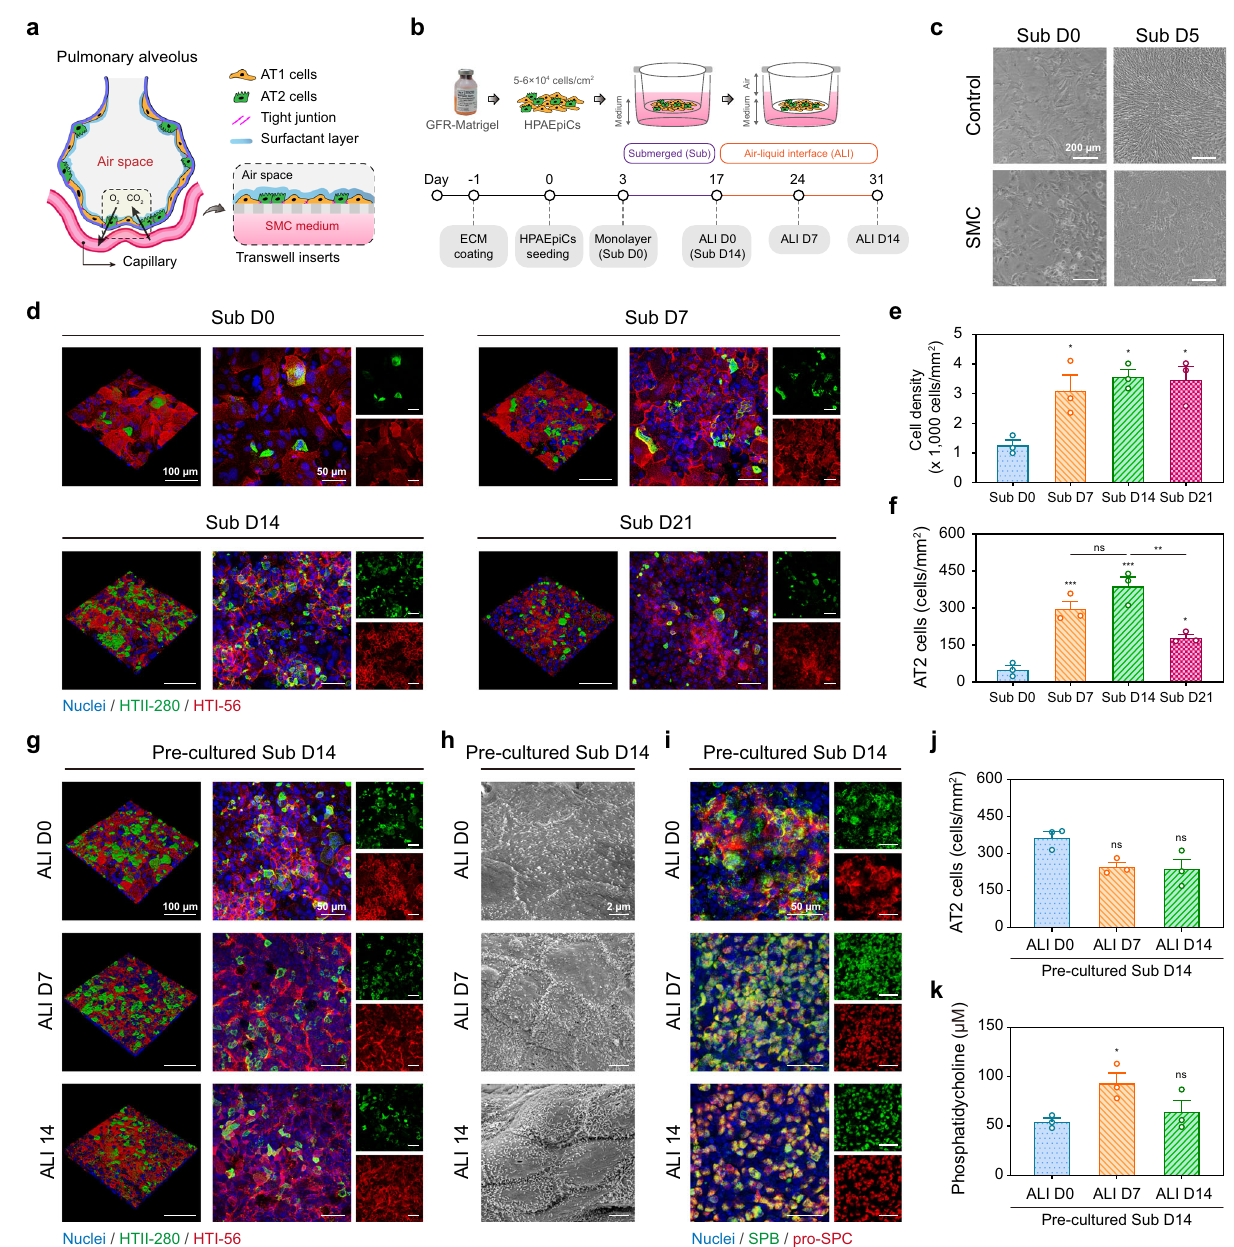
Fig. 3 Reconstitution of functional human alveolar model with ALI. a Schematic of alveolar model containing AT1 cells, AT2 cells, epithelium integrity, and surfactant layer. b Timeline fl owchart showing HPAEpiC culture steps during modeling process. The HPAEpiCs were submerged (Sub) cultured for 14 days, and then, ALI cultured for 14 days. c Bright- fi eld microscope images showing changes in HPAEpiC morphology during the modeling process. In the control medium, cells were almost elongated spindle-shaped after 5 days of Sub-culturing, whereas the SMC medium maintained an epithelial morphology. d During Sub-culturing, HPAEpiCs were stained with HTII-280 (green) and HTI-56 (red) antibodies, which are speci fi c markers for AT2 and AT1 cells, respectively. e Cell-density quanti fi cation for 21 days of sub-culturing. The HPAEpiCs proliferated signi fi cantly in the fi rst 7 days before the proliferation trend gradually stabilized. f Quanti fi cation of HTII-280 + cell (AT2 cells) populations for 21 days of Sub-culturing. The AT2 cell number reached a maximum at 14 days of culturing and then declined. g – k After 14 days of Sub pre-culturing, the HPAEpiCs initiated the ALI culture condition for 14 days of culturing. During ALI culturing, HPAEpiCs were stained with HTII-280 (green) and HTI-56 (red) antibodies ( g ), and cell microstructures were observed using a scanning electron microscope ( h ). In addition, the HPAEpiCs were stained with SPB (green) and pro-SPC (red) antibodies ( i ), both of which are speci fi c markers for AT2 cells and alveolar surfactant protein. Quanti fi cation of HTII-280 + cell (AT2 cell) populations ( j ) and PC concentration ( k ) for 14 days of ALI culturing. From g – k , ALI culturing enhances the epithelium integrity and surfactant production. Data and error bars represent mean ± SEM from three separate experiments. One-way ANOVA test ( e , f , j ) and Student ’ s t test ( k ). * p < 0.05; ** p < 0.01; *** p < 0.001; ns non-signi fi